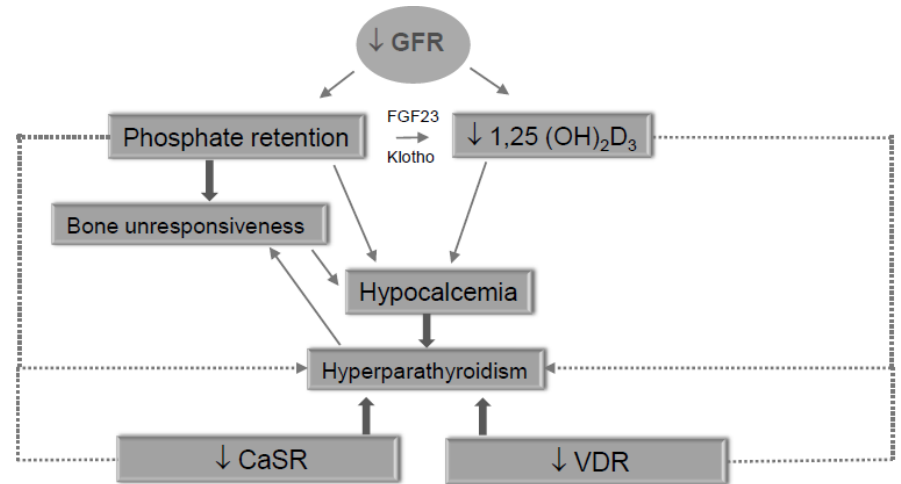
Figure 1. Pathogenesis flow-chart of SHPTH development in CKD.